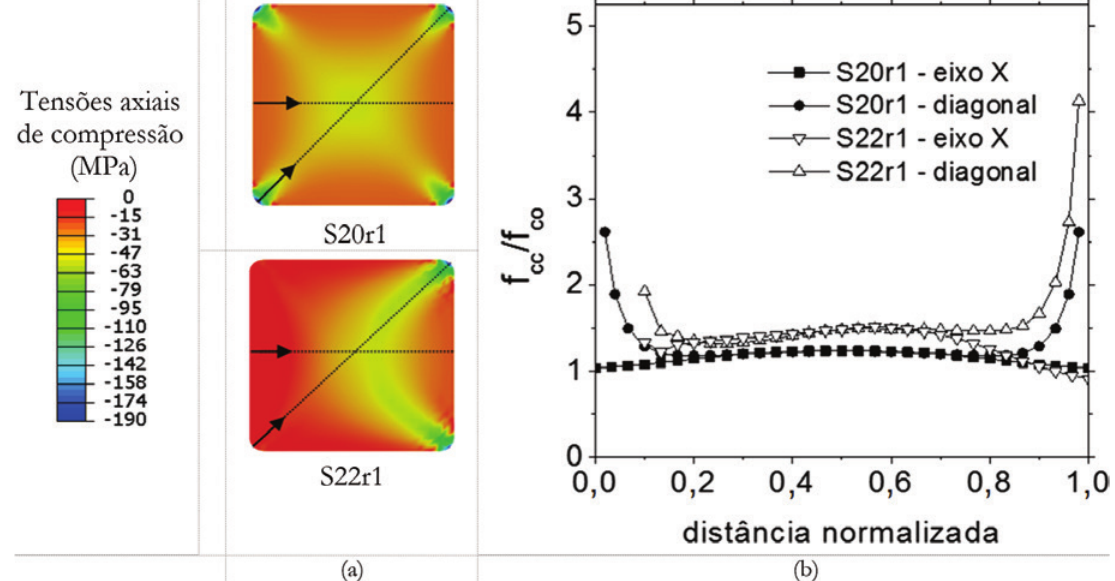
Figura 13 Tensões de compressão em pilares quadrados S20r1 e S22r1 (valores em MPa): (a) distribuição de tensões; (b) acréscimo de tensões nos trechos indicados em